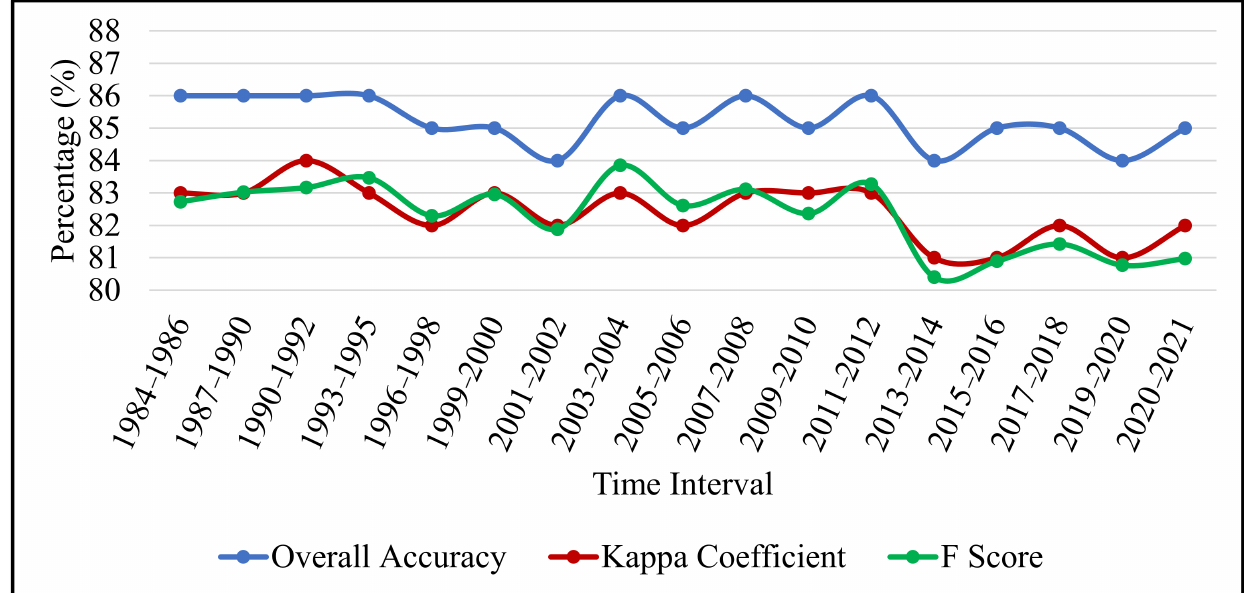
Figure 9. Overall Accuracy (OA), Kappa Coefficient (KC), and F Score values of 17 wetland maps of the Great Lakes basin between 1984 and